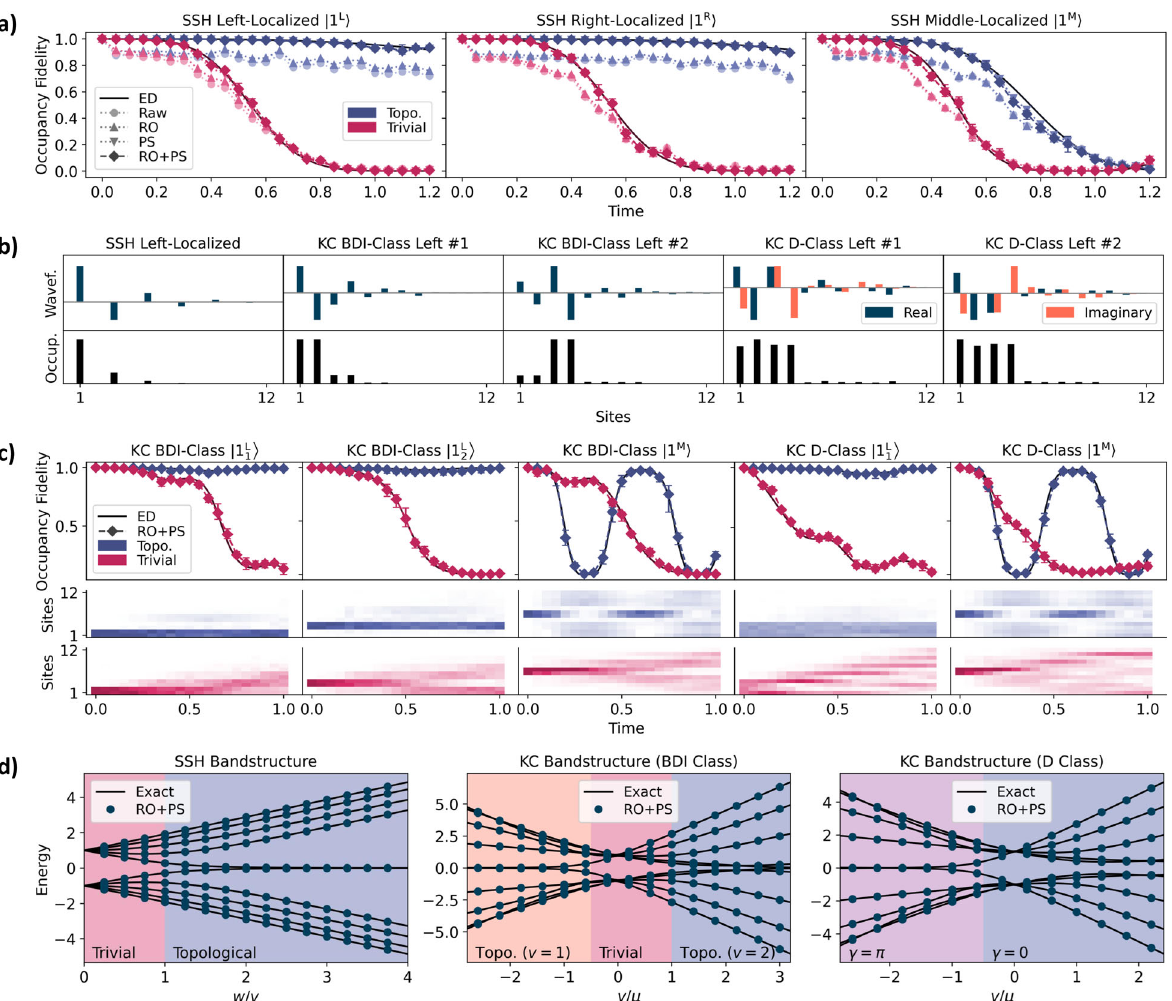
Fig. 1 Topologically robust edge states and band structures simulated on quantum computers. a 1-particle time-evolution results for the (cid:4) (cid:5) (cid:4) states when ν = 1 (topological), and rapidly SSH model H SSH , with well-preserved occupancy fi delity for perfectly boundary-localized 1 L ; R (cid:4) (cid:5) (cid:4) decaying occupancy fi delity for ν = 0 (trivial) cases and the middle-localized 1 M state. While raw hardware data already agrees qualitatively with exact diagonalization (ED) results, the agreement becomes excellent with RO and PS error mitigation. b Exact topological state wavefunctions at the left boundary, which constitute the dominant components of our 1-site, 2-site and 4-site boundary-localized initial states detailed in Table 1. c 1-particle time-evolved occupancy fi delity and spatial state density for BDI-class H KC in topological ( ν = 2) and trivial ( ν = 0) phases; and D-class H KC with ϕ = π /4 in topological ( γ = 0) and trivial phases. Again, boundary localized states persist much longer when the system is topological, despite not being exact eigenstates. Middle initial states recur periodically due to boundary re fl ection from fi nite system length. d IQPE-obtained single-particle band structures for H SSH and H KC , with topological phase transitions marked by changes in 2 ν , the number of degenerate midgap ( E = 0) states. For H KC , parameters are held at v 1 = v 2 = Δ 1 = Δ 2 ≡ v , with ϕ = 0 for BDI-class and ϕ = π /4 for D-class. Time-evolution results are computed on chains with N = 6 unit cells ( n = 12 qubits), with error bars obtained from repeated experiments across different qubit chains and machines ( ibmq_paris , ibmq_toronto , ibmq_manhattan , and ibmq_boeblingen ); band structure results are on n = 10 chains with an additional ancilla qubit, with error bars smaller than plot markers. Detailed parameter speci fi cations are given in Table